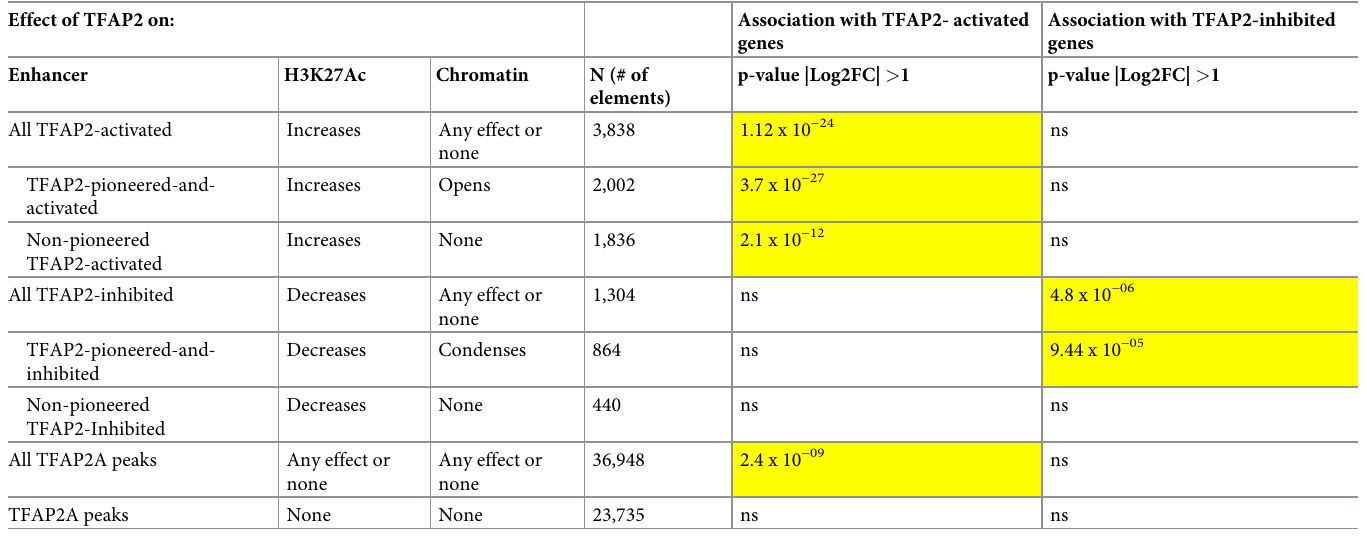
Table 1. TFAP2-regulated enhancers and their association with TFAP2-regulated genes (Fisher’s Exact Test, hypergeometric analysis). Effect of TFAP2 on: Association with TFAP2- activated